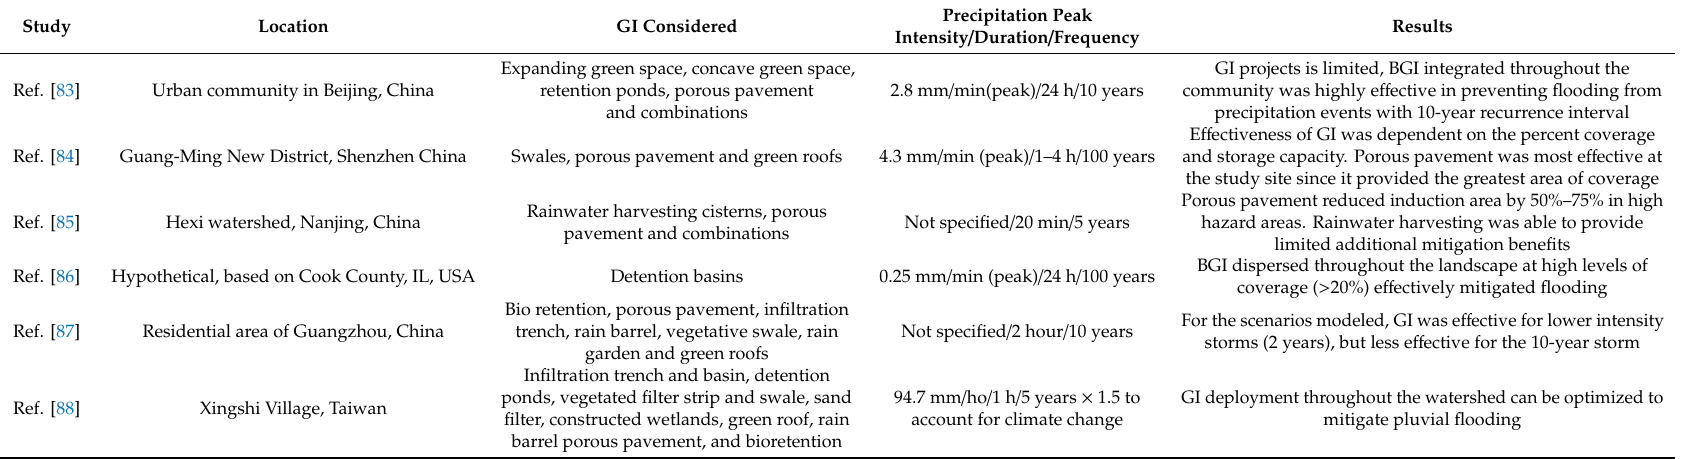
Table 2. Studies on flood mitigation e ff ectiveness of GI practices